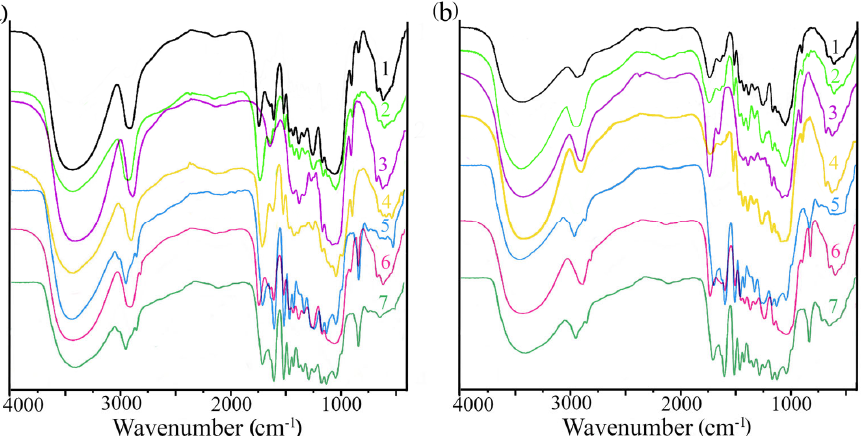
Figure 5. FTIR spectra for initial, pretreated and hydrolyzed apricot seed shells ( a ) and walnut shells ( b ): 1—initial materials; 2–4—solids, alkaline and steam explosion pretreatment, respectively; 5–7— respective solids after enzymatic hydrolysis with industrial cellulase Cellic CTec2 enzyme complex.